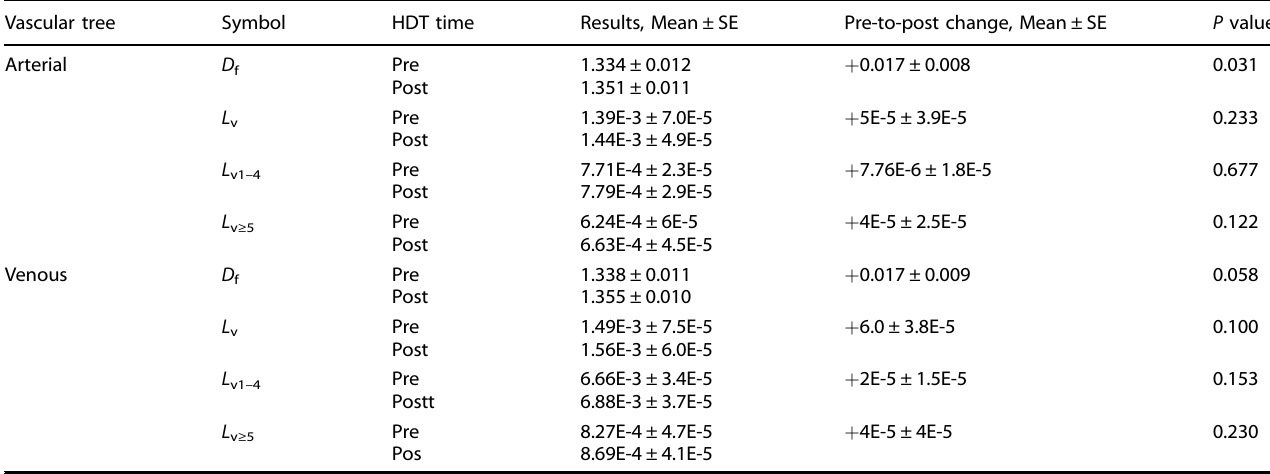
Table 2. Change of arterial and venous density in retinas of 6° HDT subjects after 70 days of bed rest. Vascular tree